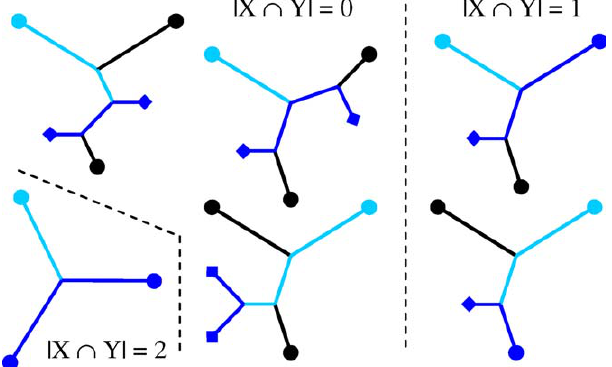
Figure 4. Topologically Distinct Phylogenetic Trees for Two Sets of Species, X and Y, such that j X j ¼ 2 and j Y j ¼ 3. X and T X are depicted in dark blue, leaves in Y are denoted with circles, and a possible choice for x (satisfying the requirements in the lemma), with the path from T X to x, in light blue. DOI: 10.1371/journal.pgen.0010071.g004